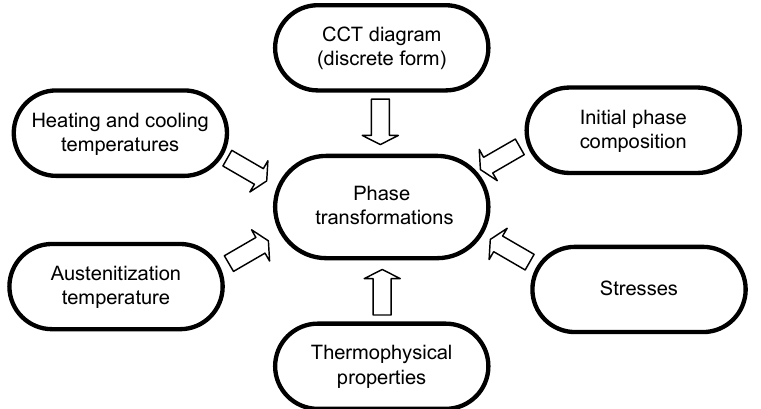
Figure 1. Basic elements affecting the kinetics of phase transformations in the solid